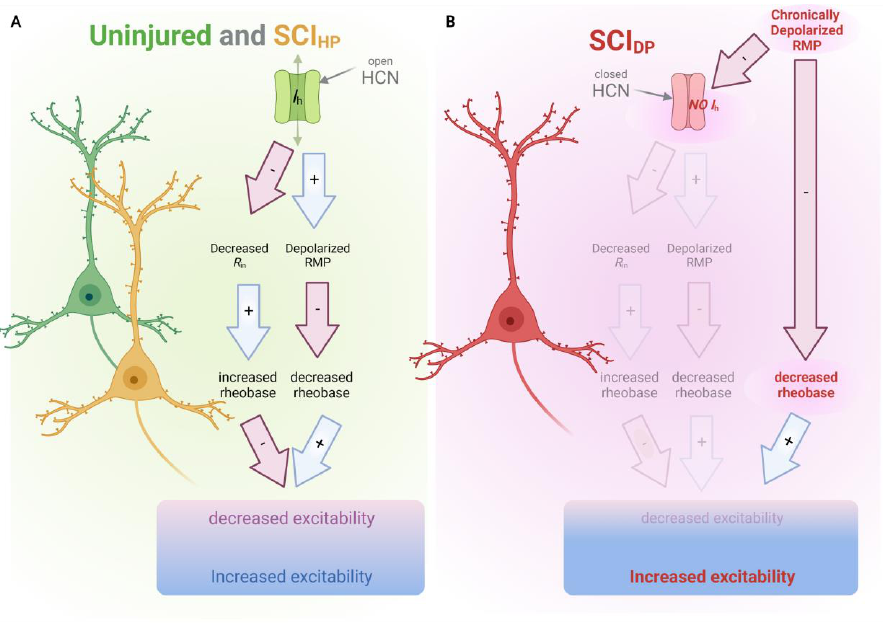
Figure 5. Model of physiological consequences of reduced HCN activation in SCI DP . ( A ) In uninjured neurons, and in axotomized SCI HP neurons, physiological levels of HCN channel activation elicit I h currents, which decrease the R in (which, in turn, increases the rheobase) and depolarize the RMP (which, in turn, decreases the rheobase). Thereby physiological HCN channel activation mediates both positive and negative regulation of neuronal excitability, and the two control components are in balance. ( B ) In axotomized SCI DP neurons, chronic RMP depolarization causes decreased HCN channel activation and a consequent lack of HCN-mediated regulation of neuronal excitability. Additionally, chronic depolarization has per se an influence on the rheobase, contributing to increased excitability directly. Thus, the components that control neuronal excitability are imbalanced. Image created with Biorender.com (accessed on 16 January 2023; agreement number XB24WB0WTV).